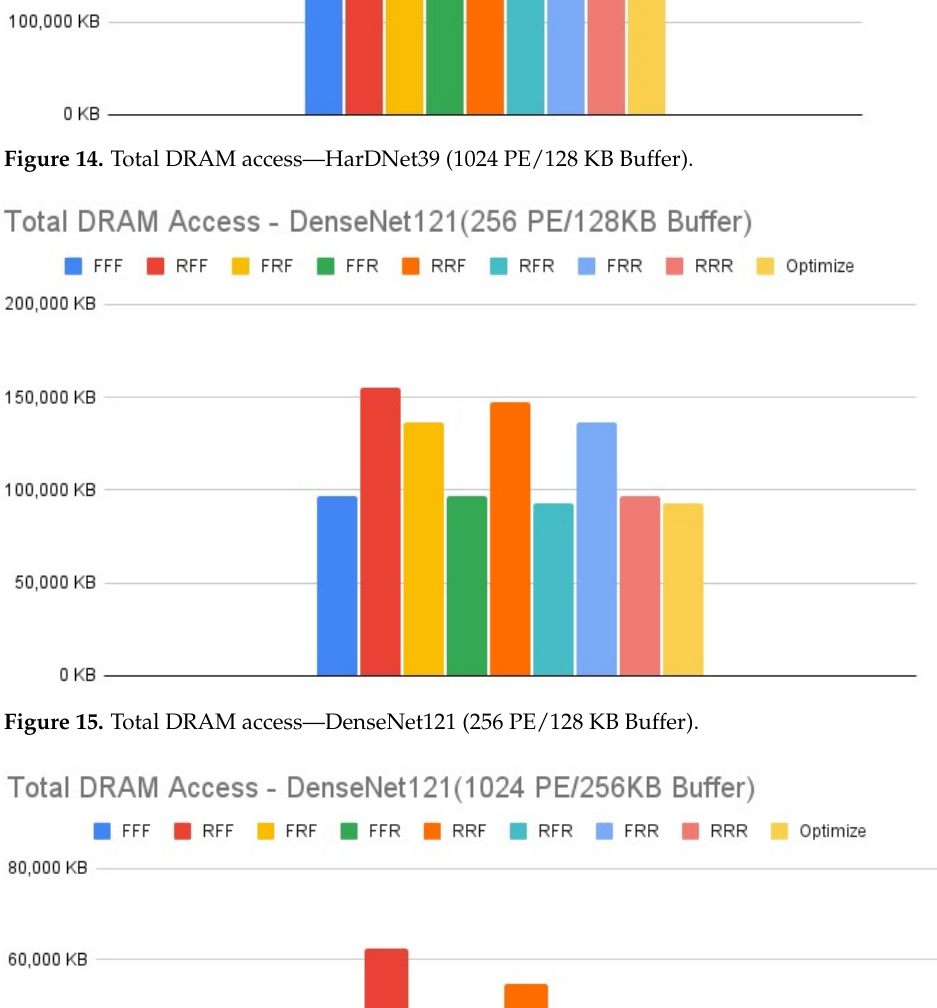
Figure 15. Total DRAM access—DenseNet121 (256 PE/128 KB Buffer).